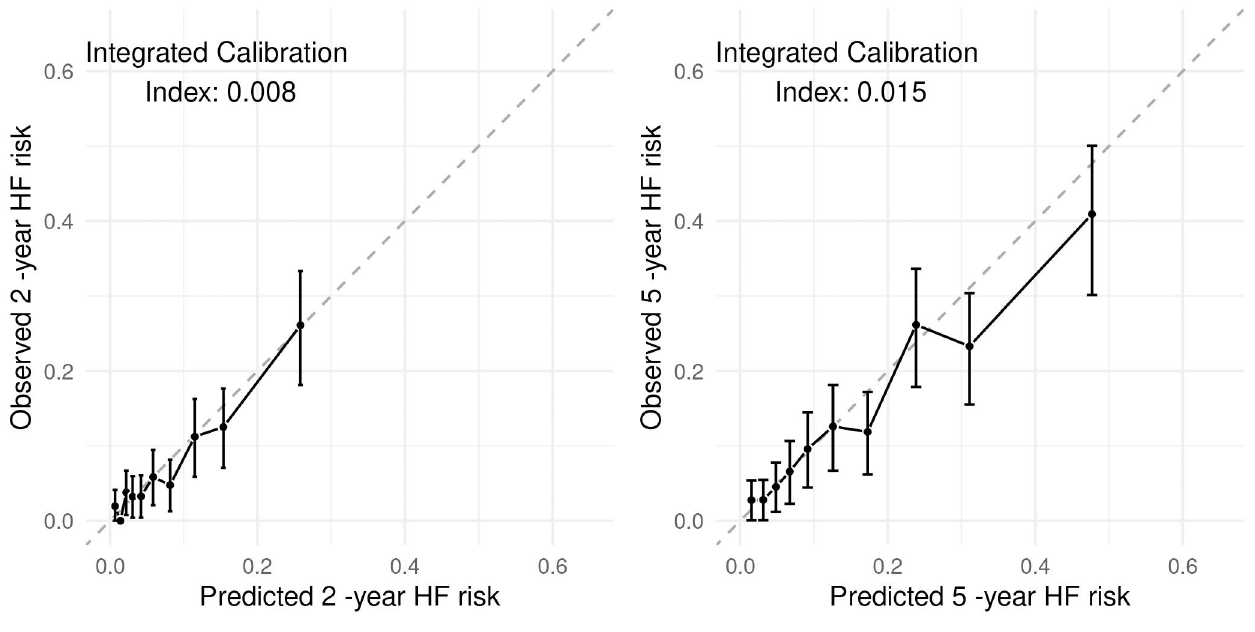
Fig 4. Calibration for the PHNN